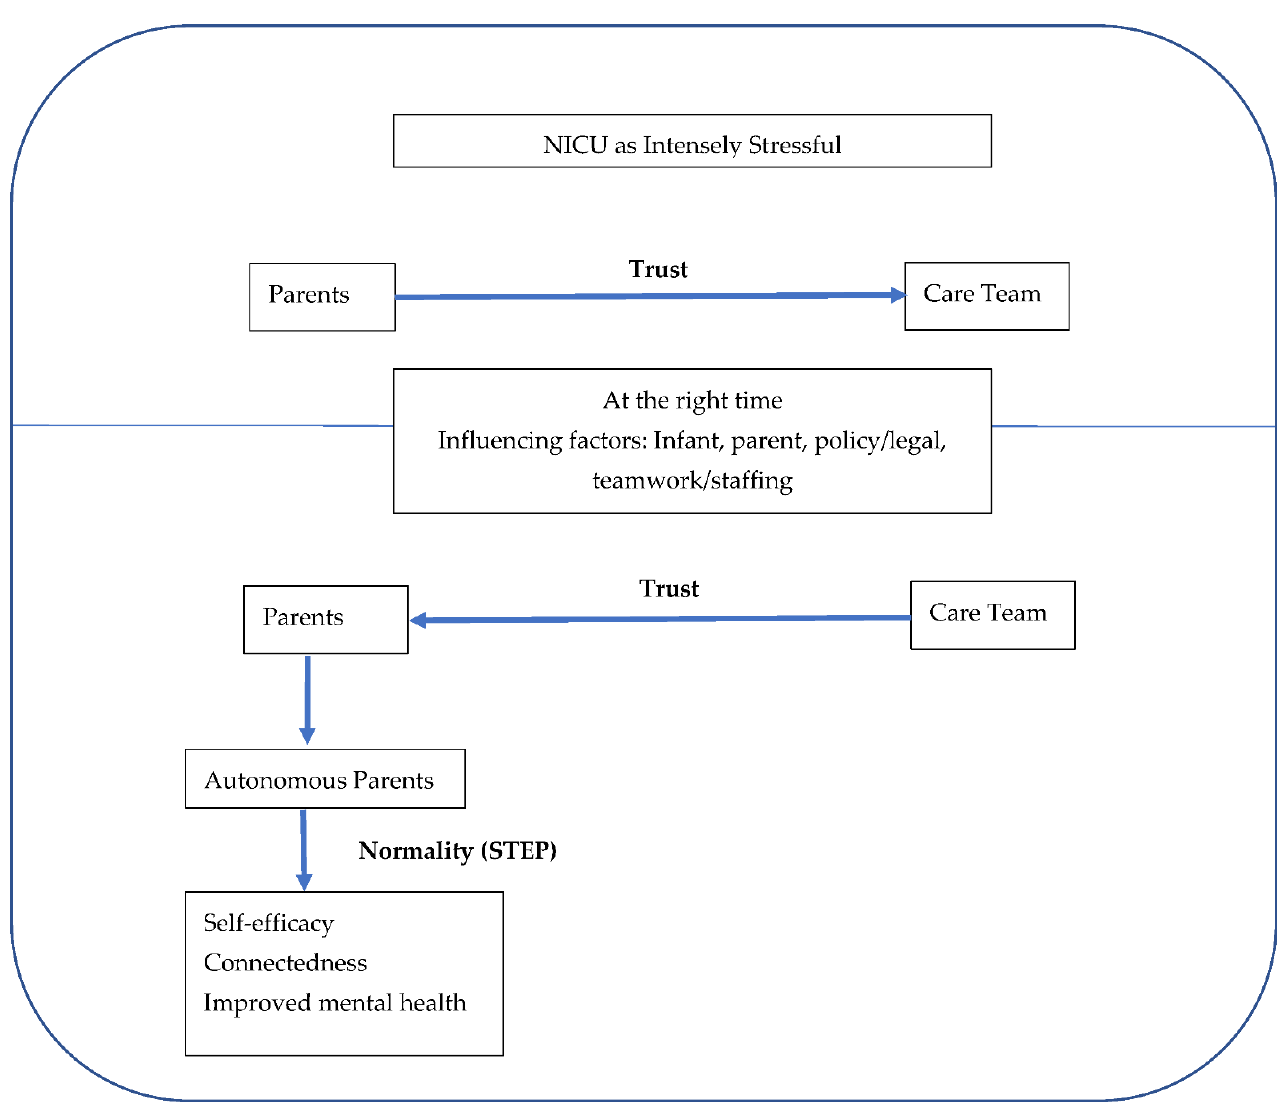
Figure 1. Trust and Normality enabling Self-efficacy and Connectedness in NICU